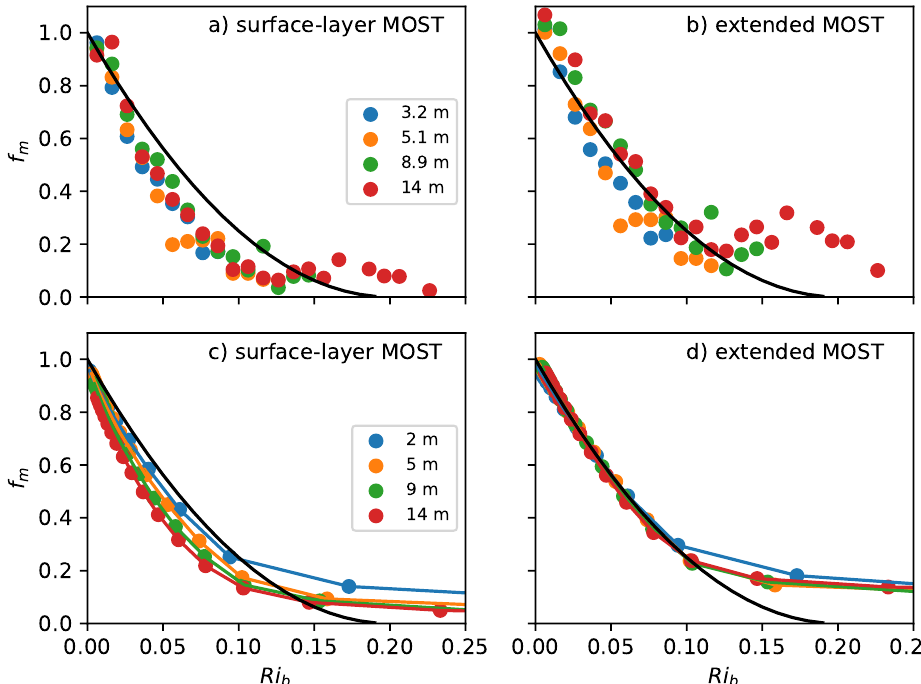
Figure 9. Normalized drag coefficient f m as a function of the bulk Richardson number based on SHEBA observations ( a , b ) and single-column modeling results ( c , d ). The left panels correspond to surface layer MOST; right panels, to the extended MOST. The black solid line corresponds to the Businger–Dyer relation